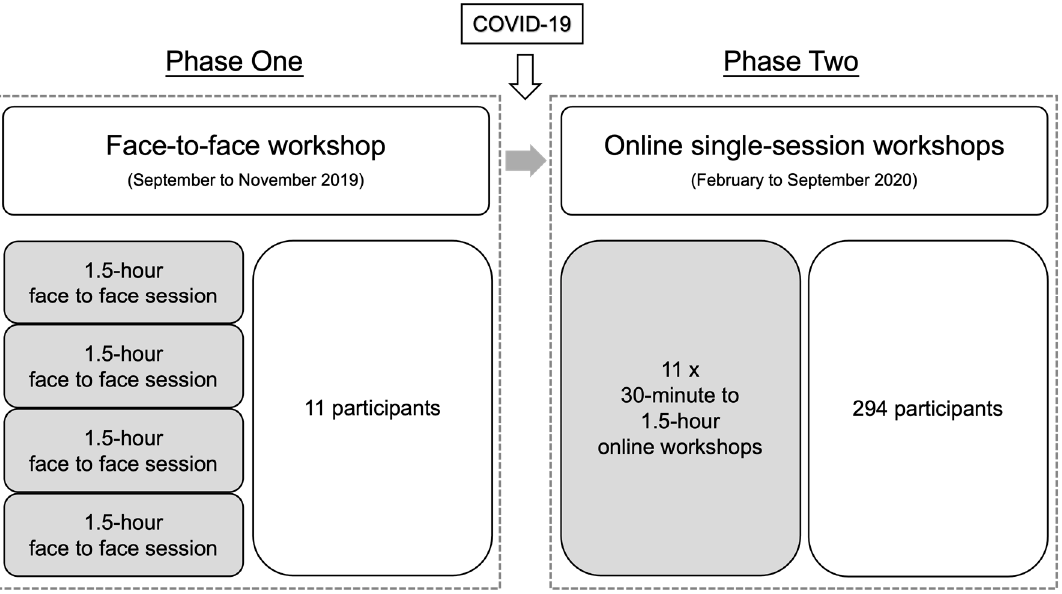
Figure 1. Study phases and design of the Caritas Aberdeen Integrated Family Service Centre (IFSC) Zentangle art program.